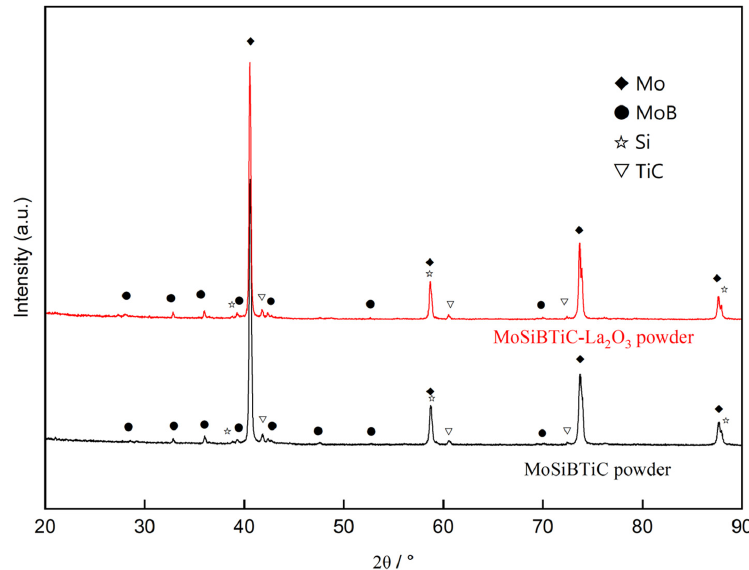
Figure 3. XRD patterns of the FD-POEM MoSiBTiC-La 2 O 3 and MoSiBTiC powders.